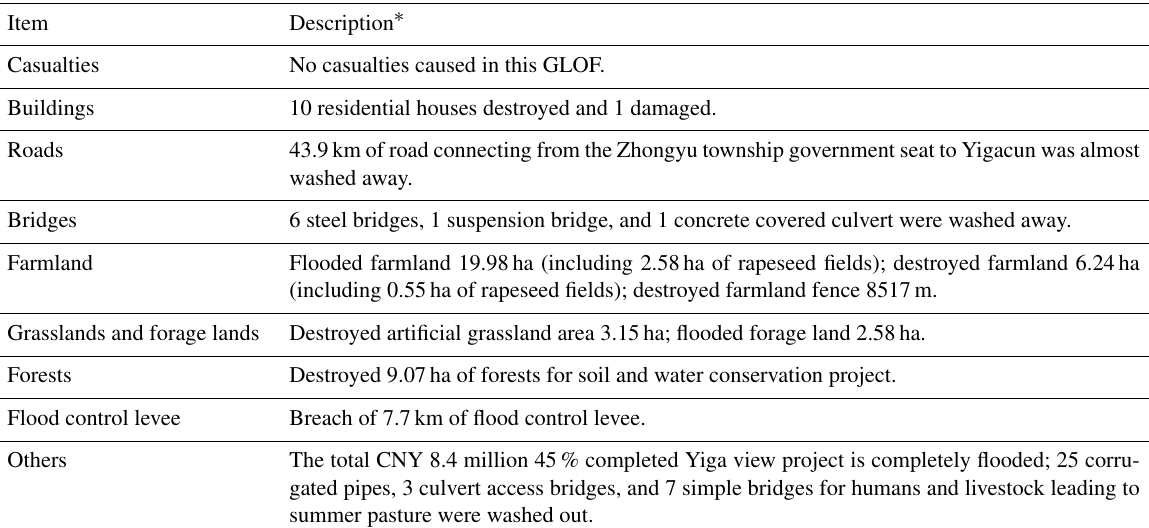
Table 3. Details of the damages and losses caused by the GLOF of 26 June 2020.